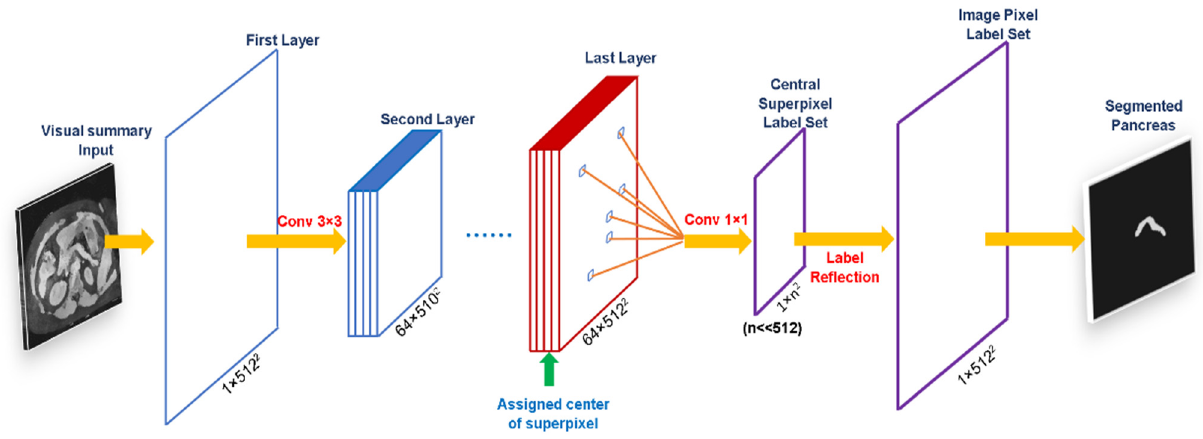
Figure 2. The framework of the DCNN. The assigned center of superpixels accelerated the speed of DCNN.